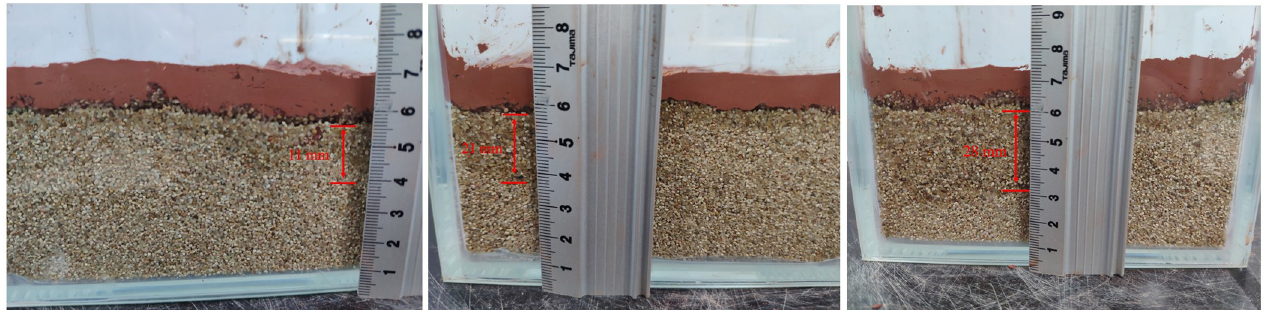
Fig 15. Infiltration of 11 mm thick naturally weathered red-bed soil films after dropping 0.1 mol/L NaOH (A) 0.1 mol/L NaOH dropped on an 11 mm thick naturally weathered red-bed soil film for 3 min; (B) 0.1 mol/L NaOH dropped on an 11 mm thick naturally weathered red-bed soil film for 6 min; (C) 0.1 mol/L NaOH dropped on an 11 mm thick naturally weathered red-bed soil film for 9